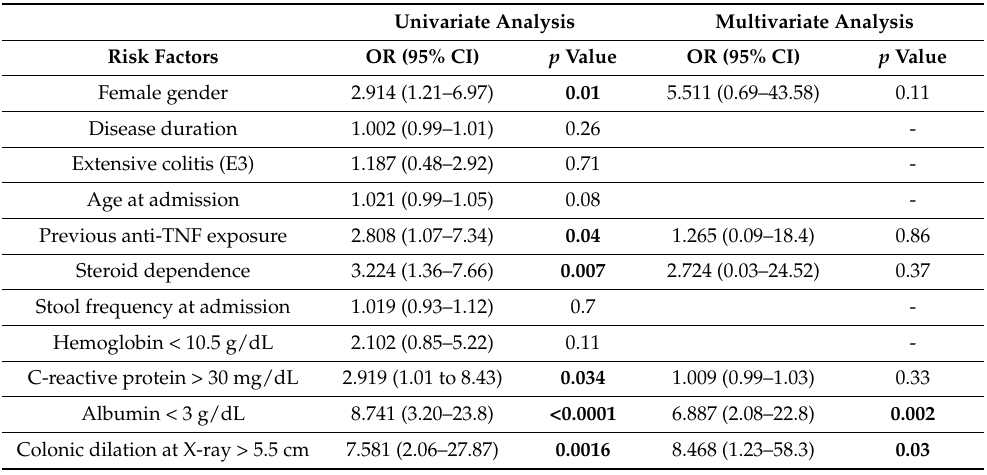
Table 2. Predictive variables associated with colectomy in 116 patients with acute severe ulcerative colitis responding to intravenous corticosteroids or infliximab.